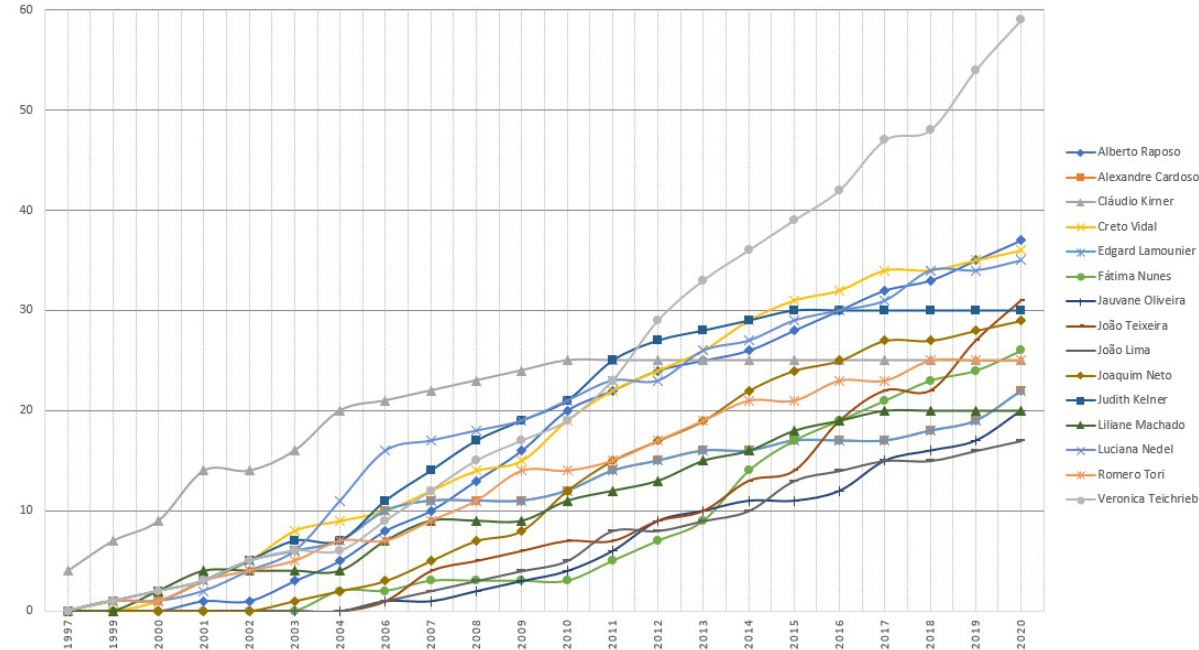
Figure 21. How the number of publications for each of the 15 most active authors increased over the events (in chronological order).